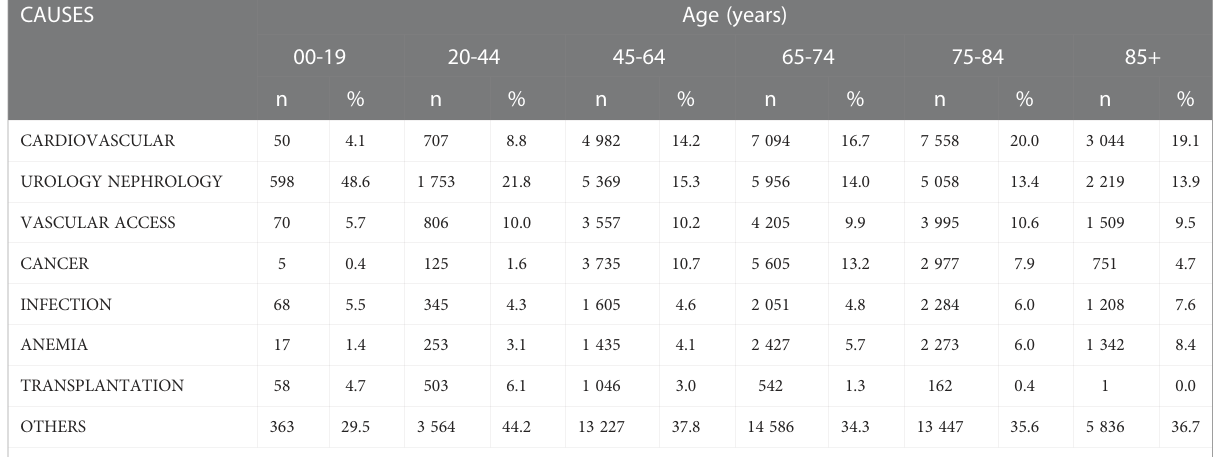
TABLE 2 Cause of hospitalization according to age (source REIN registry linked to hospital database).